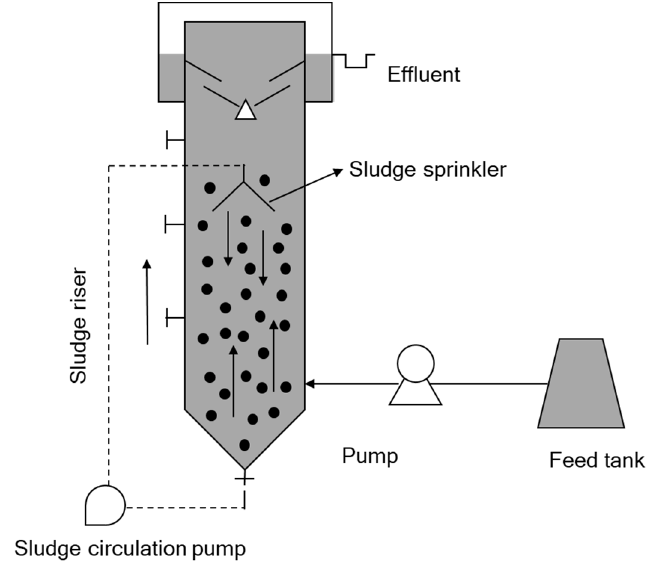
Figure 1. A schematic view of the hydrolysis reactor.